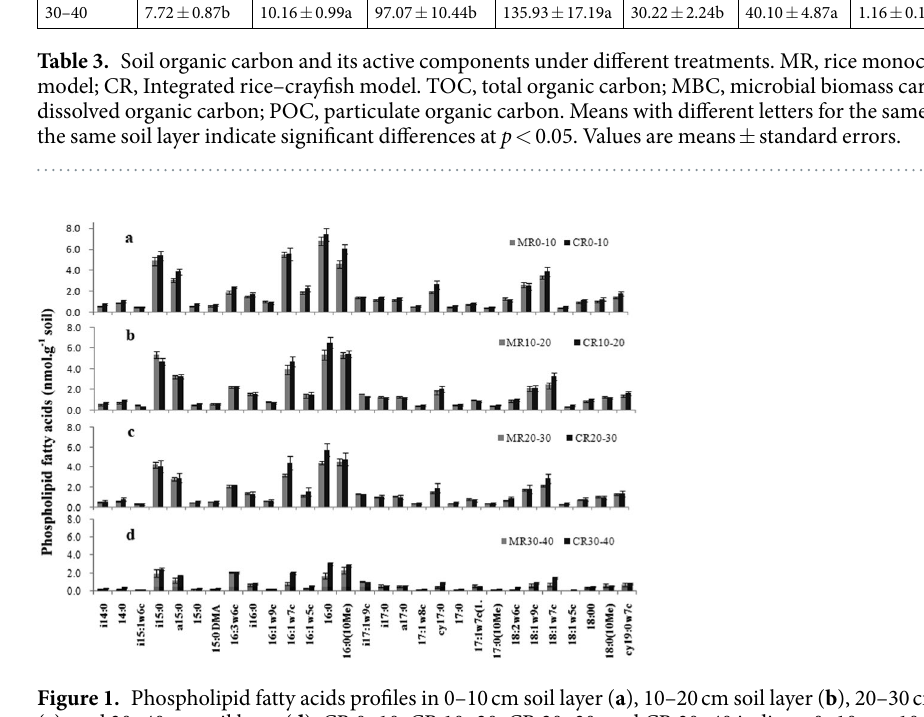
Figure 1. Phospholipid fatty acids profiles in 0–10 cm soil layer ( a ), 10–20 cm soil layer ( b ), 20–30 cm soil layer ( c ), and 30–40 cm soil layer ( d ). CR 0–10, CR 10–20, CR 20–30, and CR 30–40 indicate 0–10 cm, 10–20 cm, 20–30 cm, and 30–40 cm soil layers in the integrated rice–crayfish model; MR 0–10, MR 10–20, MR 20–30, and MR 30–40 indicate the soil layers in the rice monoculture